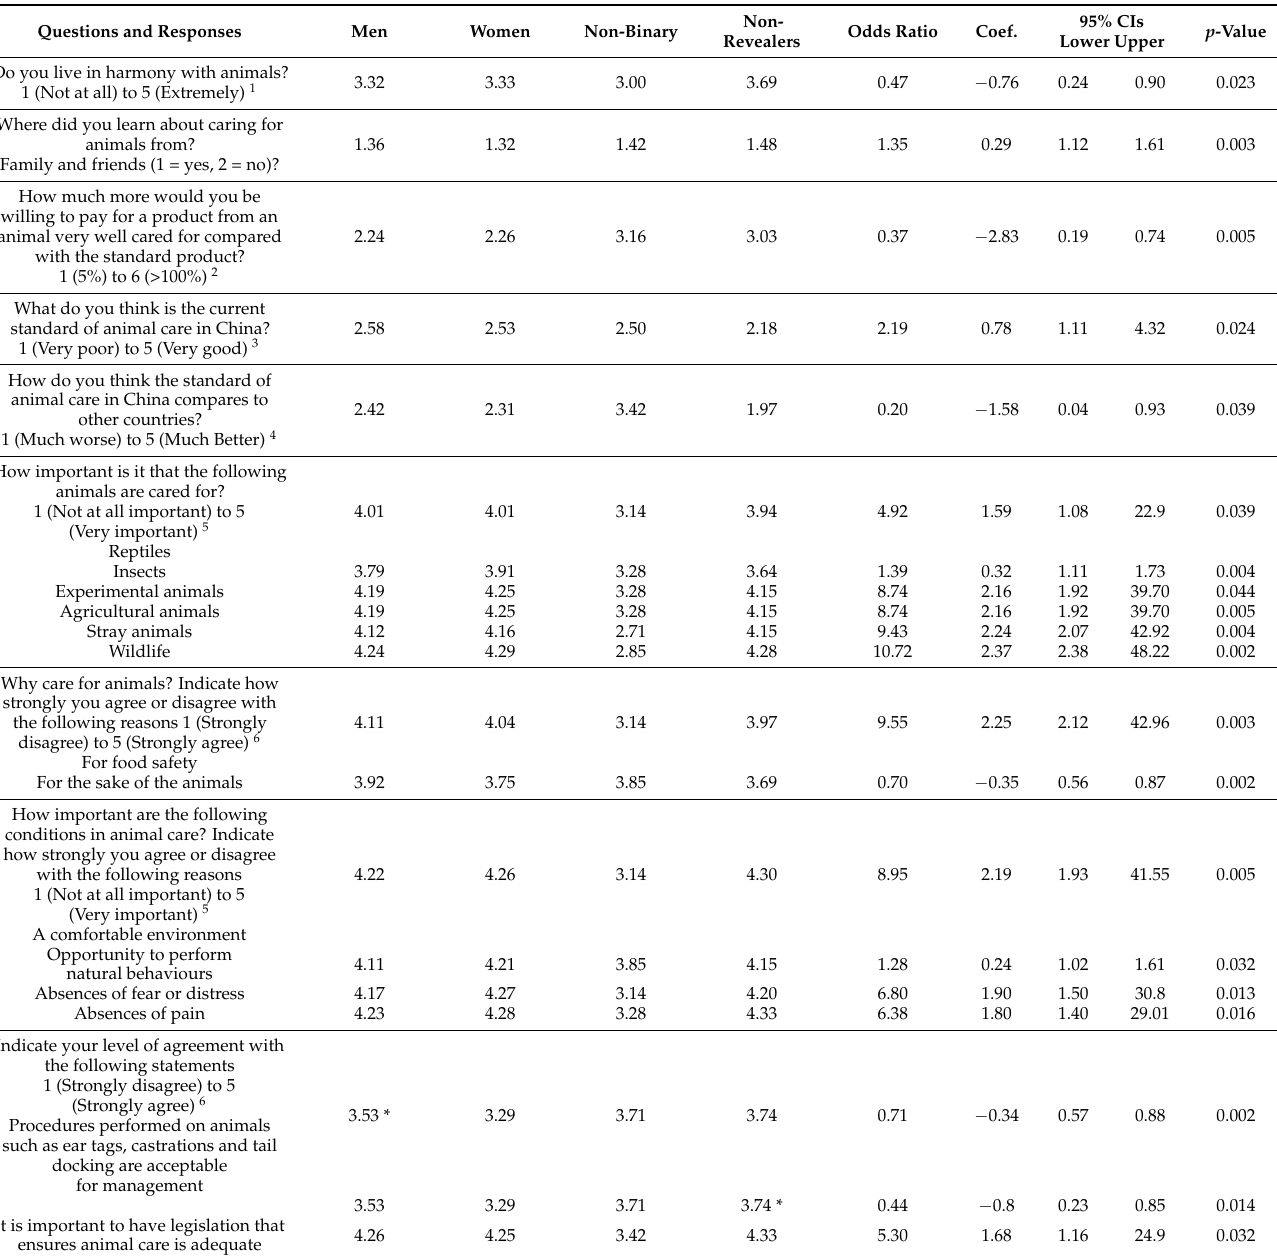
Table 2. Gender effects on respondents’ attitudes towards animal welfare in China. Mean responses on 5-point ordinal scales are provided. Differences are presented between Men (n = 618), Women (n = 628), Non-binary participants (n = 7) and Non-revealers (n =